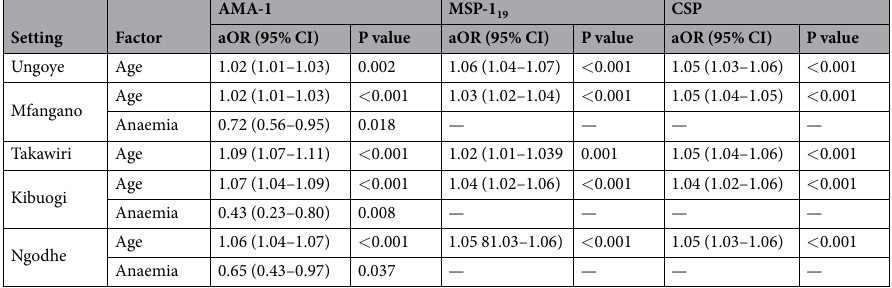
Table 3. Factor associated with P . falciparum seroprevalence in four islands and a mainland village, Lake Victoria Kenya, 2012 * . * aOR, adjusted odd ratio; CI, confidence interval. Estimates are adjusted (i.e. age, gender, fever and anaemia) for correlation between observations from the same